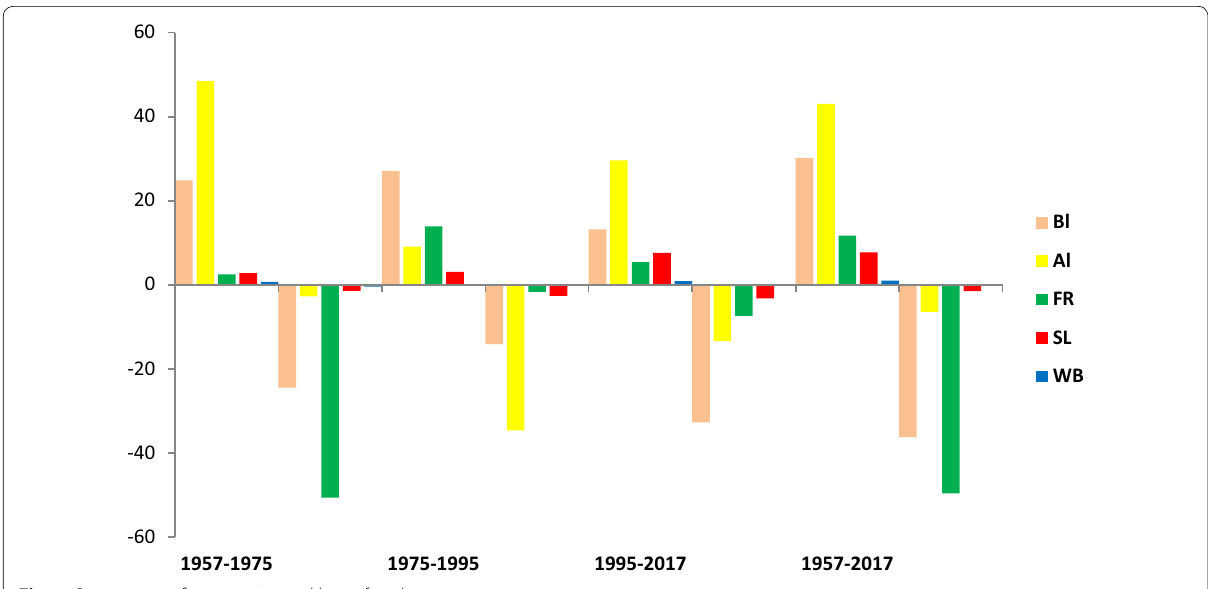
Fig. 5 Percentage of gross gains and loss of each